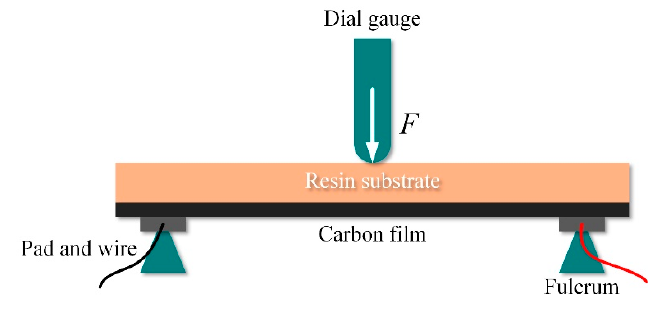
Figure 10. The results of ( a ) the resistance measurement; and ( b ) the three-point bending test.